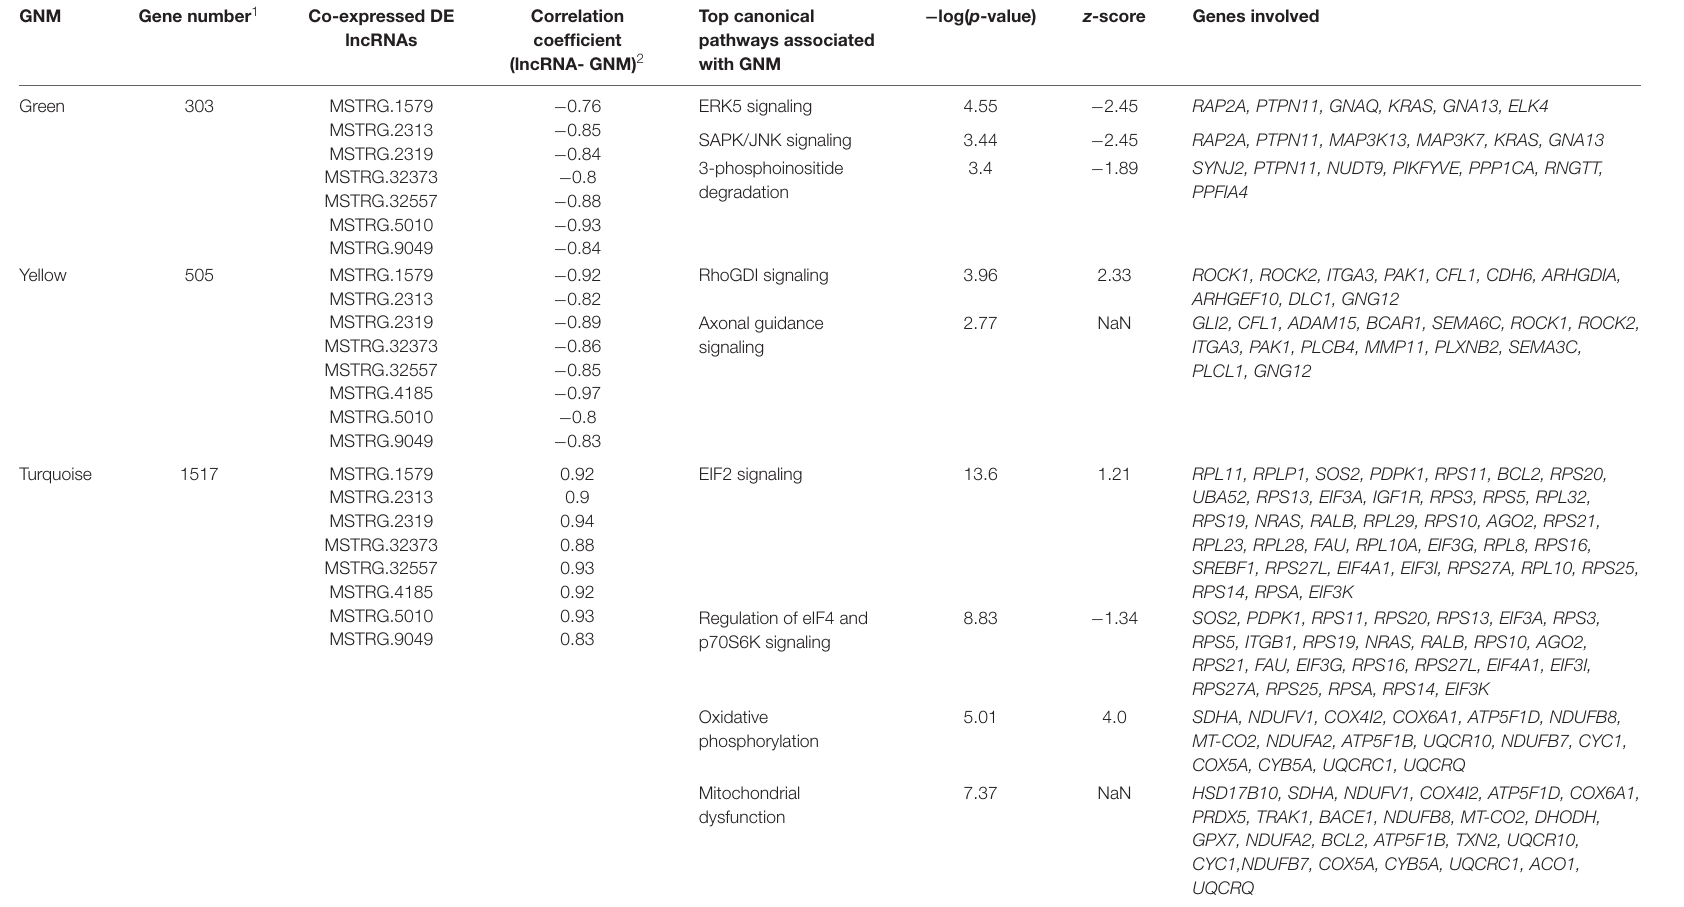
TABLE 2 | Significant gene modules and canonical pathways associated with differentially expressed ( DE) lncRNAs. GNM Gene number 1 Co-expressed DE